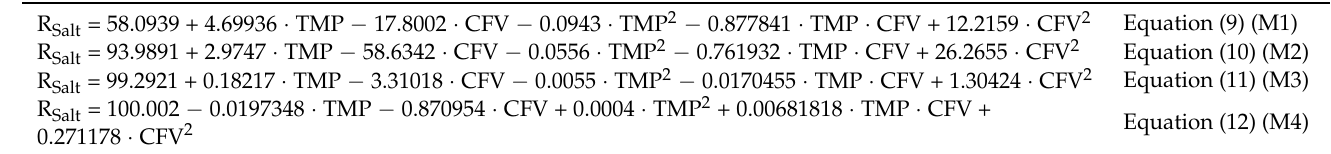
Table 8. Equations from the multiple regression statistical model for R salt (total recycle mode).